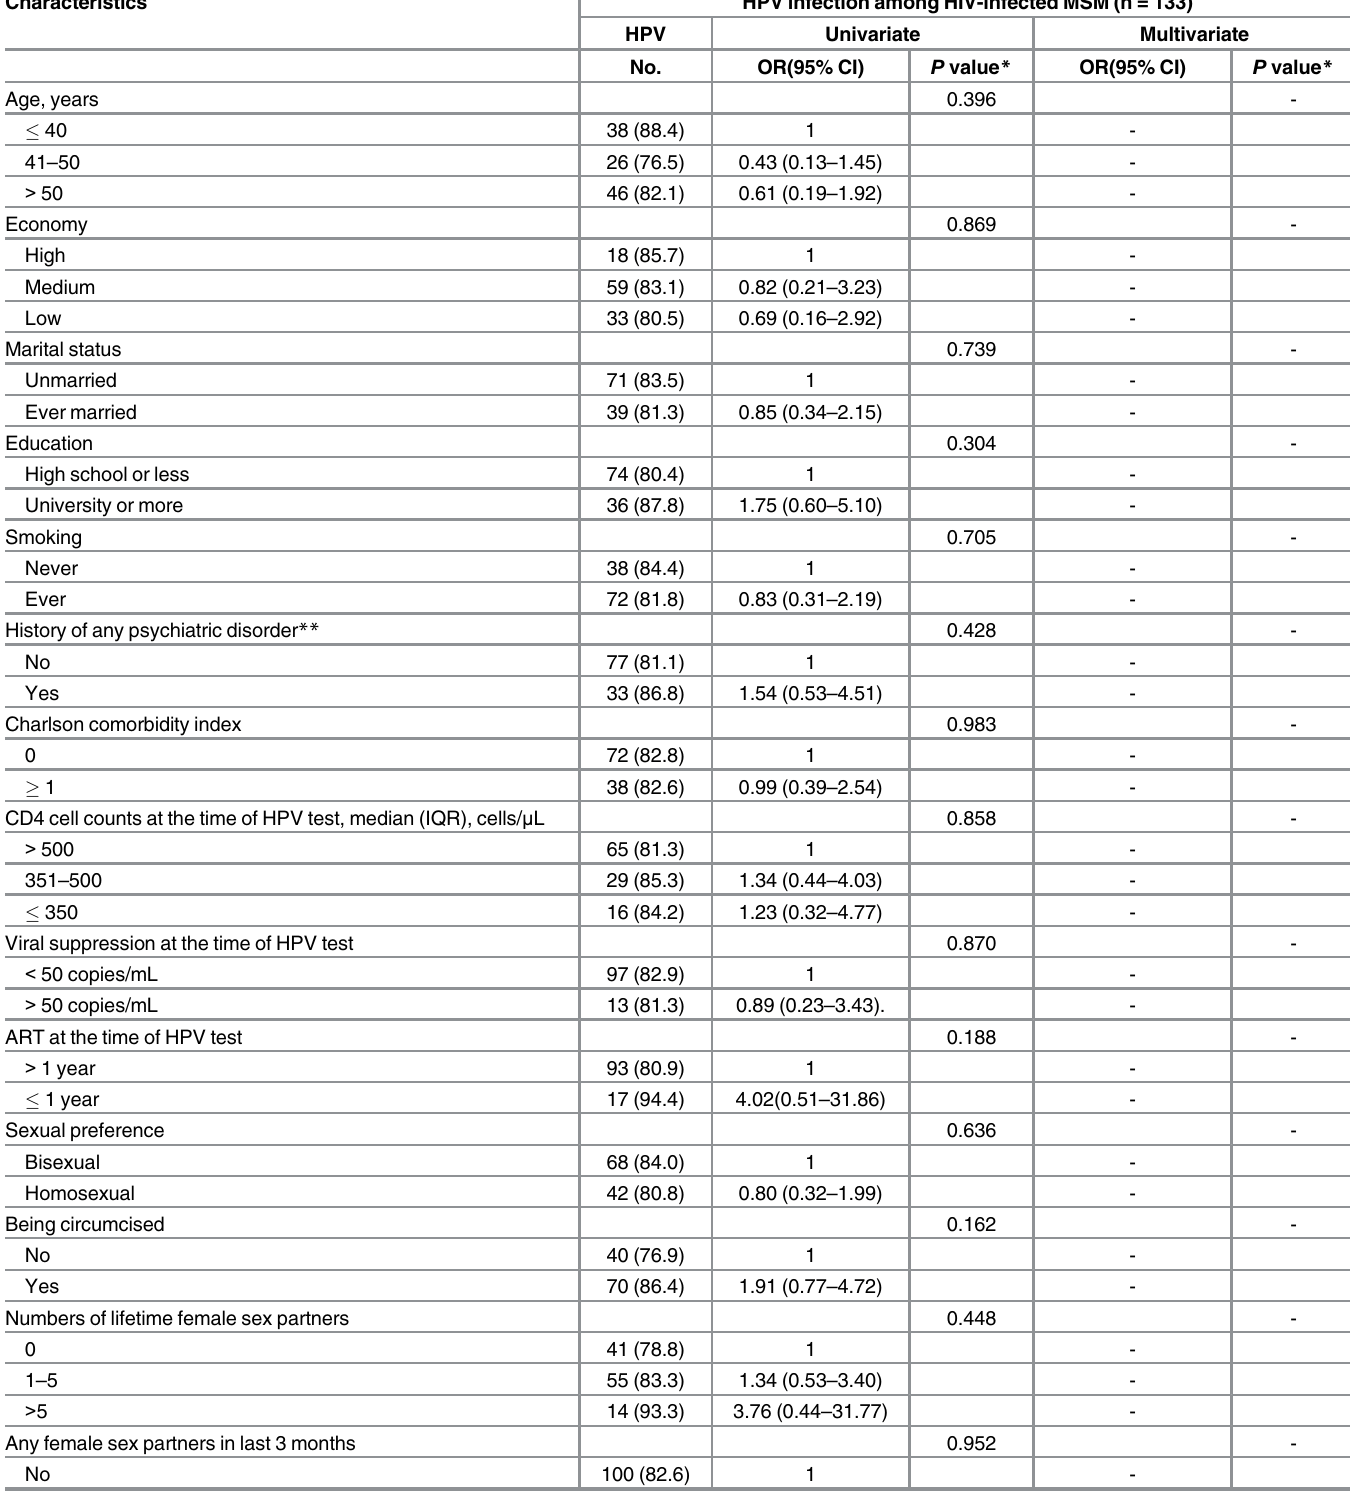
Table 3. Univariable and multivariable analyses of determinants of anal human papillomavirus infection in HIV-infected Men who have sex with men.